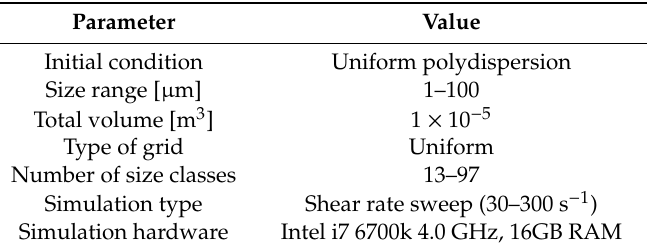
Table 1. Grid independence test parameters.